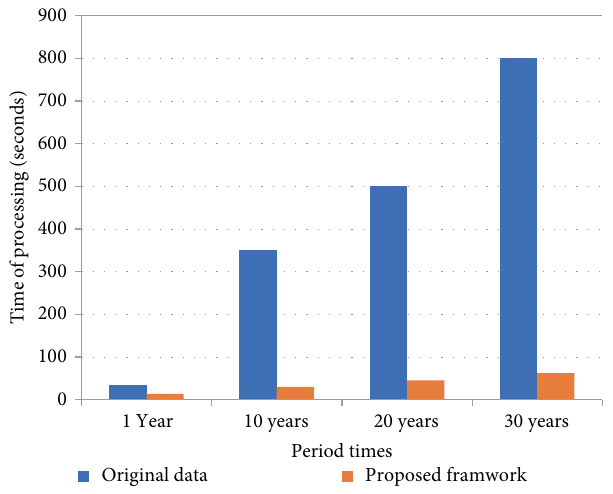
Figure 10: Bar chart for time processing for original data and proposed framework in different period of times.